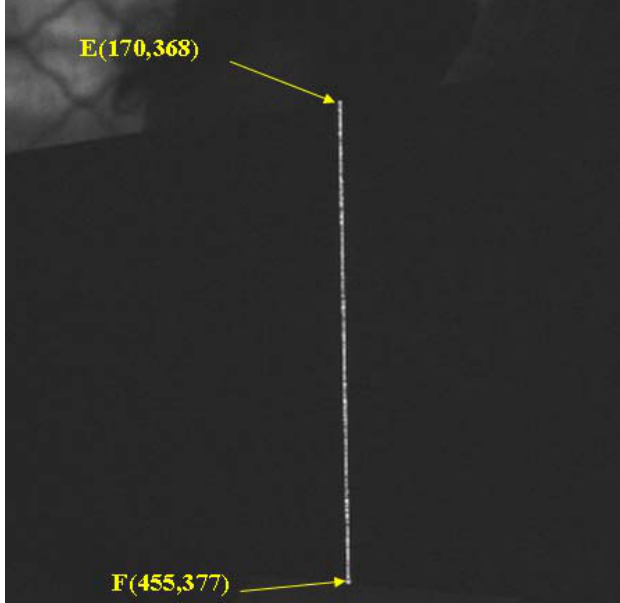
Figure 10. Image of the standard block.